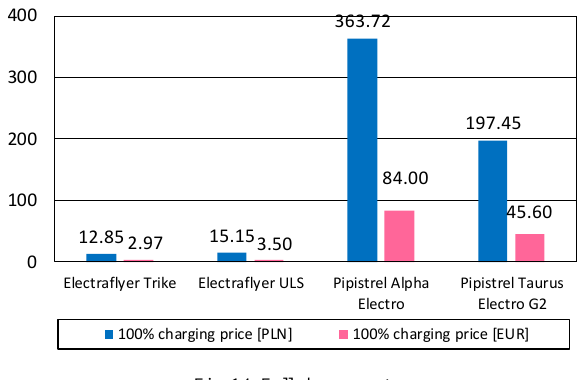
Fig. 14. Full charge